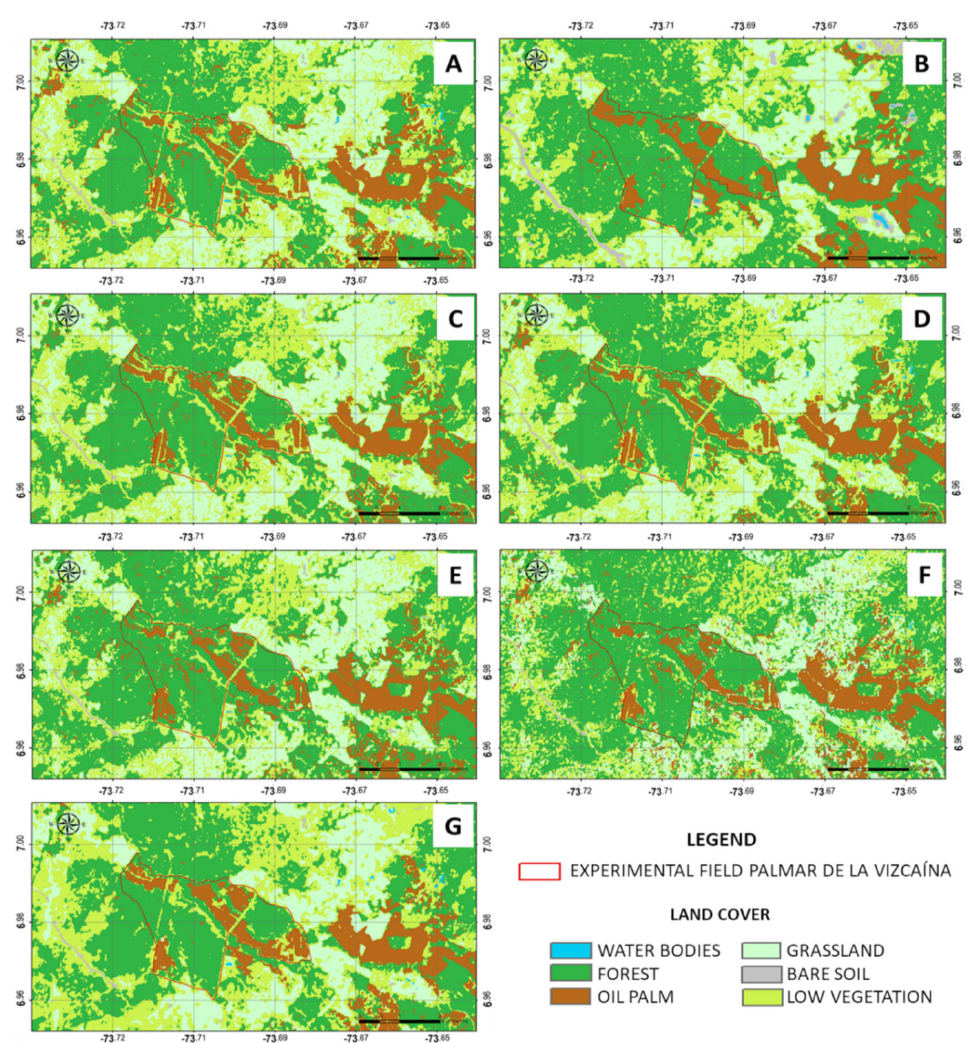
Figure 6. Results of land cover classifications using RF algorithm. Classification of optical ( A ) and SAR images ( B ). Classification images fused by BR method ( C ), HFM method ( D ), GS method ( E ), PC method ( F ) and optical/SAR image stack ( G )